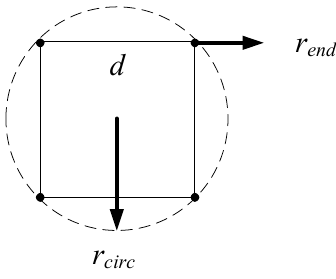
Figure 2. Schematic diagram of the equivalent radius.